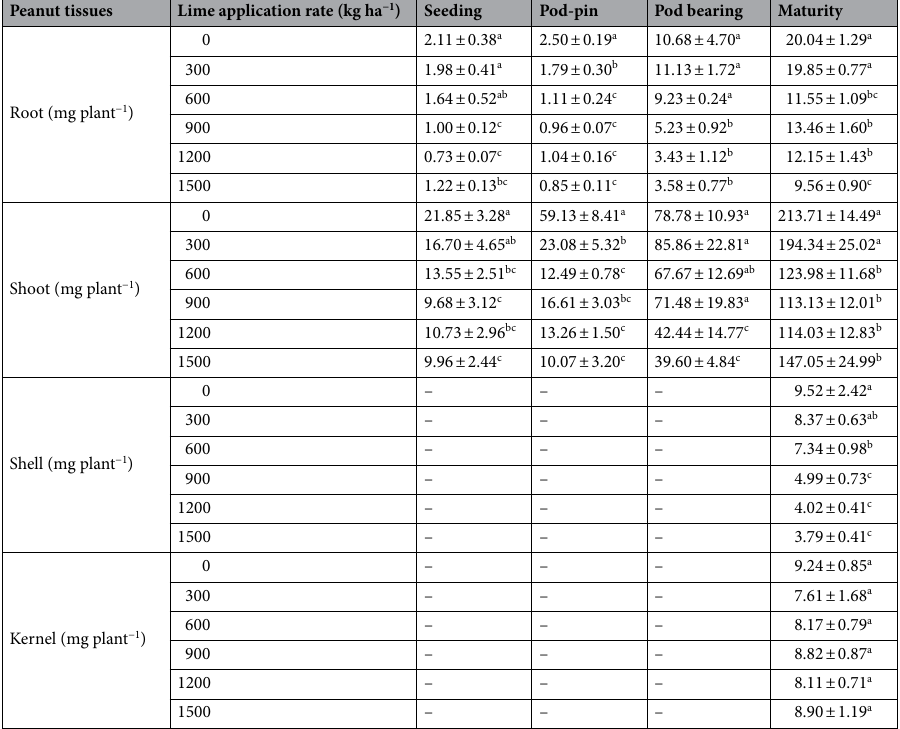
Table 3. Effects of slaked lime applications on Cd accumulations in peanut tissues in the different growth stages. Values are means (± SD) of three replicates. Different lowercase letters indicate a significant difference ( p < 0.05) among six treatments of slaked lime within the same growth